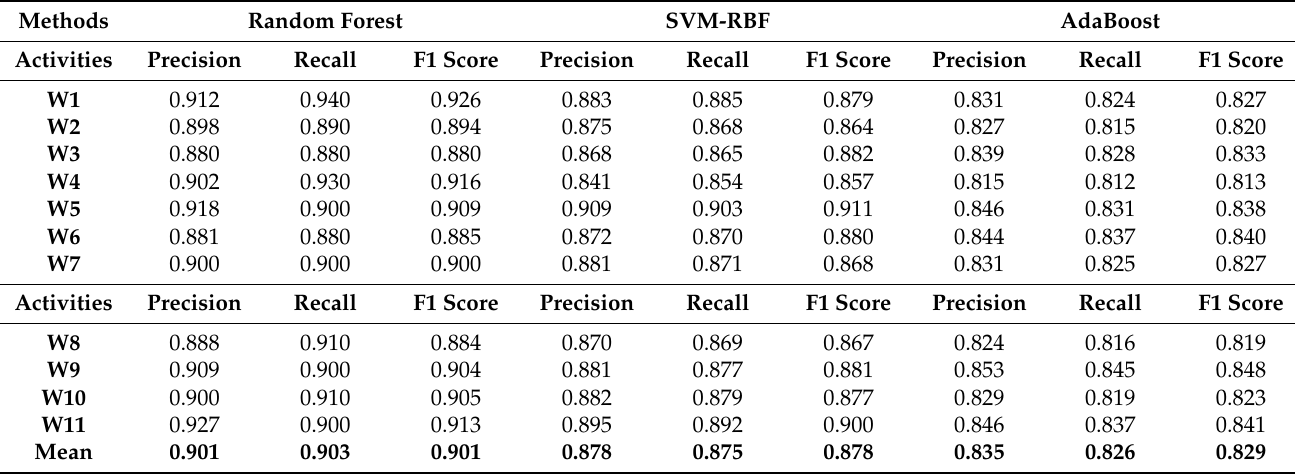
Table 2. Comparison of the evaluation metrics (precision, recall, and F1 score) of the HPAR model from the IM-WSHA dataset.